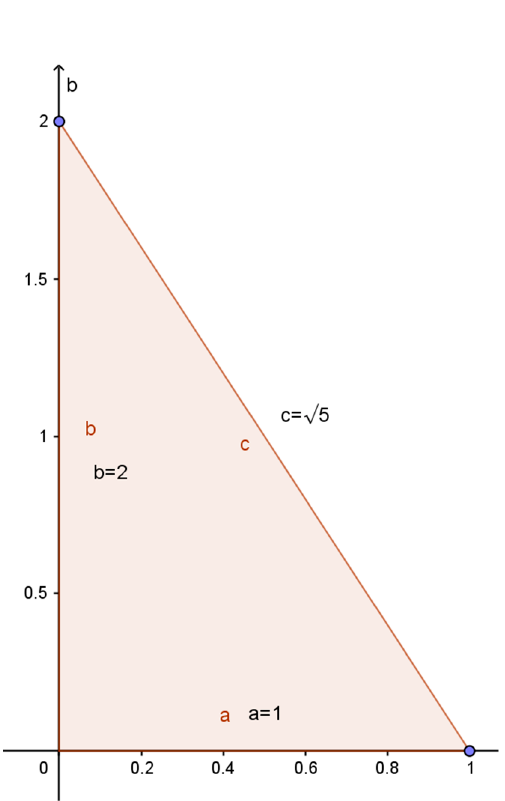
Figure 2. Right-angled triangle representation of the golden ratio.